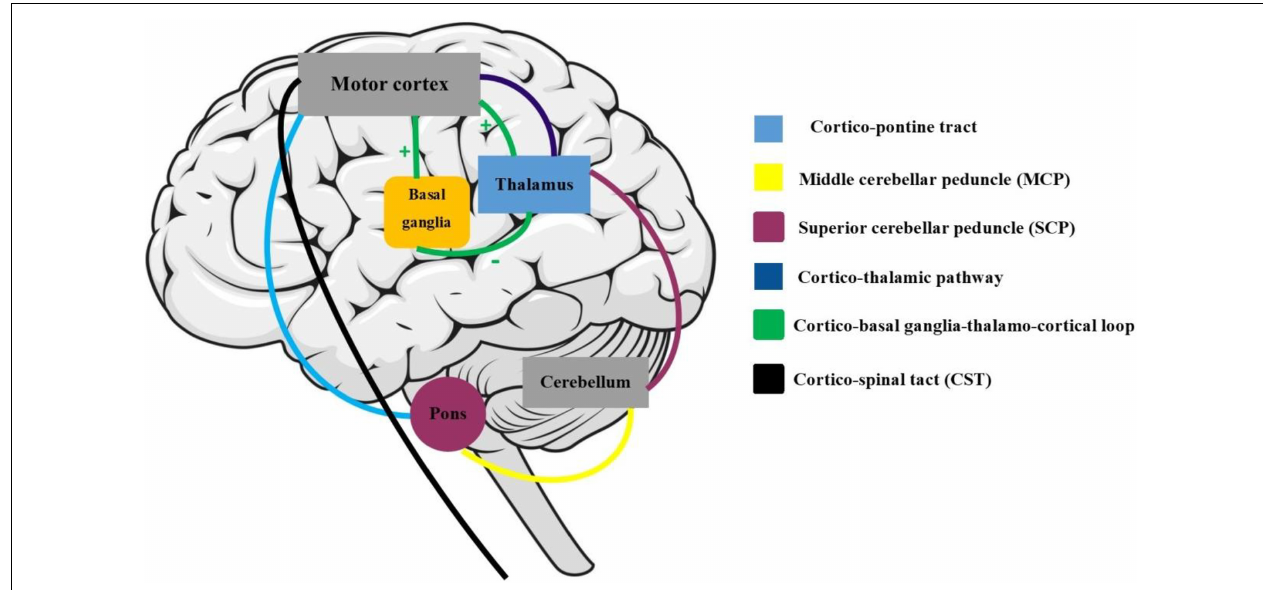
FIGURE 5 | Motor and somatosensory system: the maturation of cortico-spinal tract (CST) is responsible for smooth and fine movements of limbs. The basal ganglia and cerebellum modulate the CST functions through the afferent (cortex, brain stem, and spinal cord) and efferent (through the thalamus) fibers. The cortico-basal ganglia-thalamo-cortical circuit is a modulator motor system with inhibitory and excitatory inputs.